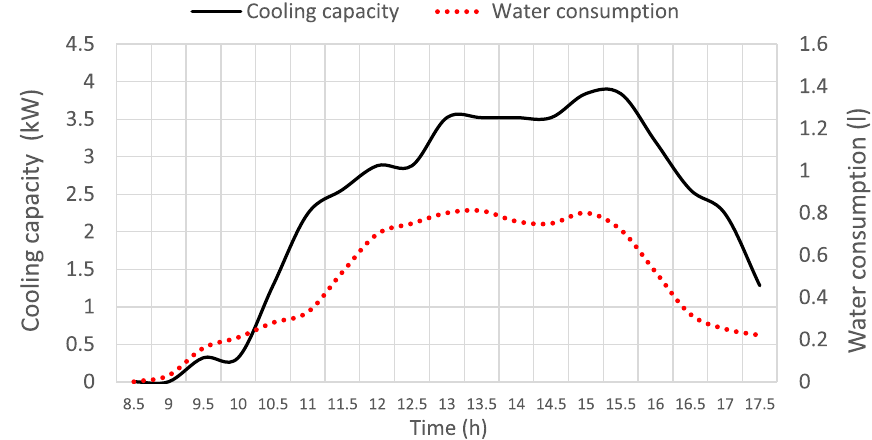
Fig. 8 Variation of cooling capacity and water consumption with time for day